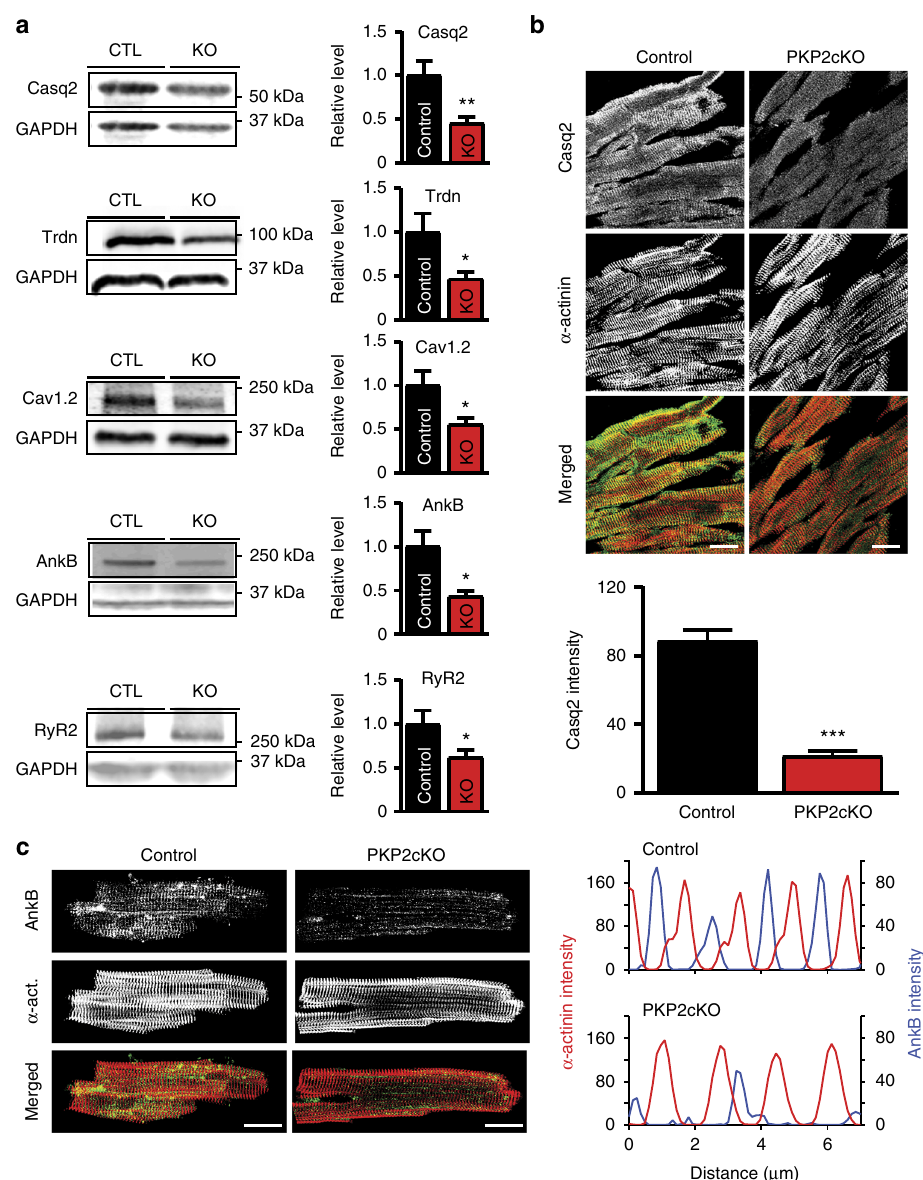
Fig. 4 Remodeling of proteins involved in calcium signaling pathways in the PKP2-cKO mouse. a Representative western blots ( left ) and average densitometry ( right ; n = 6 for all groups) measured from control (CTL) and PKP2-cKO (KO) ventricular lysates. * p < 0.05; ** p < 0.01 (Student ’ s t -test). b Immuno fl uorescence staining for Casq2 ( green ) and α -actinin ( red ) in control and PKP2-cKO ventricular sections collected at 21 dpi. Scale bar = 20 µ m. Bottom panel: quanti fi cation of Casq2 intensity in PKP2-cKO vs. control samples. Analysis from 54 images, obtained from four hearts, both for PKP2cKo and control. *** p < 0.001 vs. control. c Immuno fl uorescence staining for Ankyrin B ( green ) and α -actinin ( red ) in control and PKP2-cKO heart sections at 21 dpi. Scale bar, 20 µ m. Right panel: pro fi le expression intensity of AnkB and α -actinin in PKP2-cKO and control hearts (2D) images of three-dimensional (3D) objects, give the impression of overlap (see, e.g., ref. 23 ) and render our